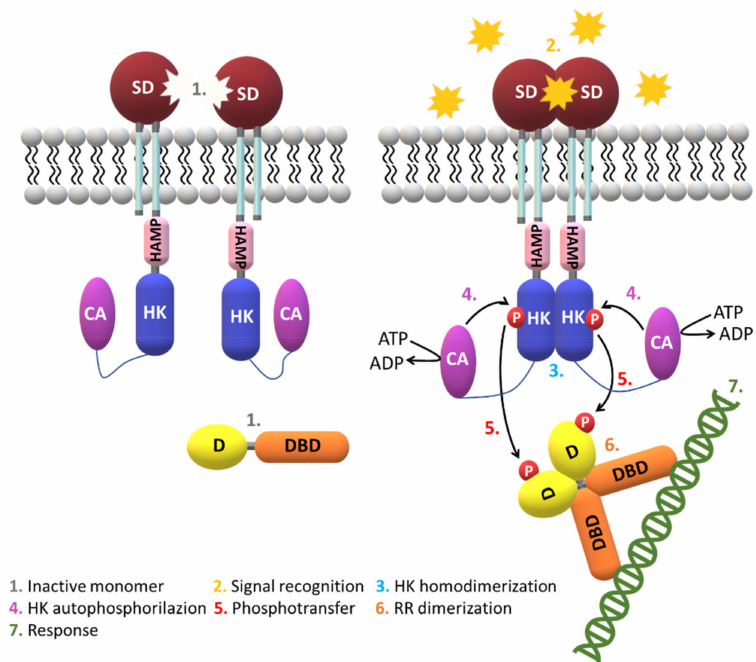
Figure 7. Prototypical TCS signaling pathway. A variety of extracellular signals are detected by the SD, which triggers the membrane-bound HK dimerization. The TM helices form four-helix bundles in the HK dimeric states. The signaling mechanism then involves the autophosphorylation of HK mediated by hydrolysis of ATP and concomitant phosphorylation of a conserved histidine by the catalytic (CA) domain. This then leads to the phosphotransfer of the HK phosphoryl group to a cytoplasmatic response regulator (RR) that is composed by two domains: the receiver domain (D)—that recognizes and binds to the HK domain—and the effector DNA-binding domain (DBD) that modulates the expression of target genes and hence the cellular response. Upon phosphorylation, the RR is activated and undergoes conformational changes that promote dimerization or more ordered oligomerization states that favor the interaction between the RR and bacterial DNA. Alternatively, the RR may also act as an enzyme, such as a methylesterase or an ATPase. TCS signaling is terminated by dephosphorylation of the RR, which can be auto induced or mediated by the HK or by auxiliary proteins. The CA and the dimerization domains are conserved and found in all HK, whereas the remaining signaling domains (HAMP, GAF, PAS and PHY) are